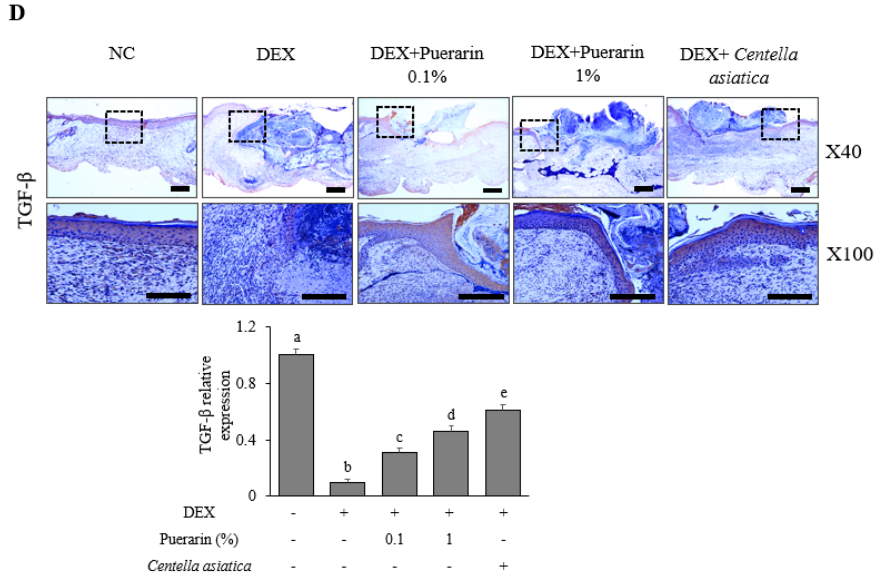
Figure 1. Effects of puerarin on cutaneous wound healing in mice treated with DEX. ( A ) Wound sizes were measured on day 0, day 7, and day 14 of the experiment. ( B ) Representative images of wounds from five groups. ( C ) Hematoxylin and eosin (H&E), Masson trichrome (M/T), and phloxine-tartrazine (P/T) stained sections of wound samples from the five groups. Scale bar: 50 μ m. ( D ) Immunohistochemical analysis (day 14) of TGF- β in the wound areas. The data are presented as the means ± SDs ( n = 6 per experiment). Bars labeled by the same letter on the graph are not significantly different from each other ( p < 0.05) by one-way ANOVA followed by post hoc Tukey’s test.